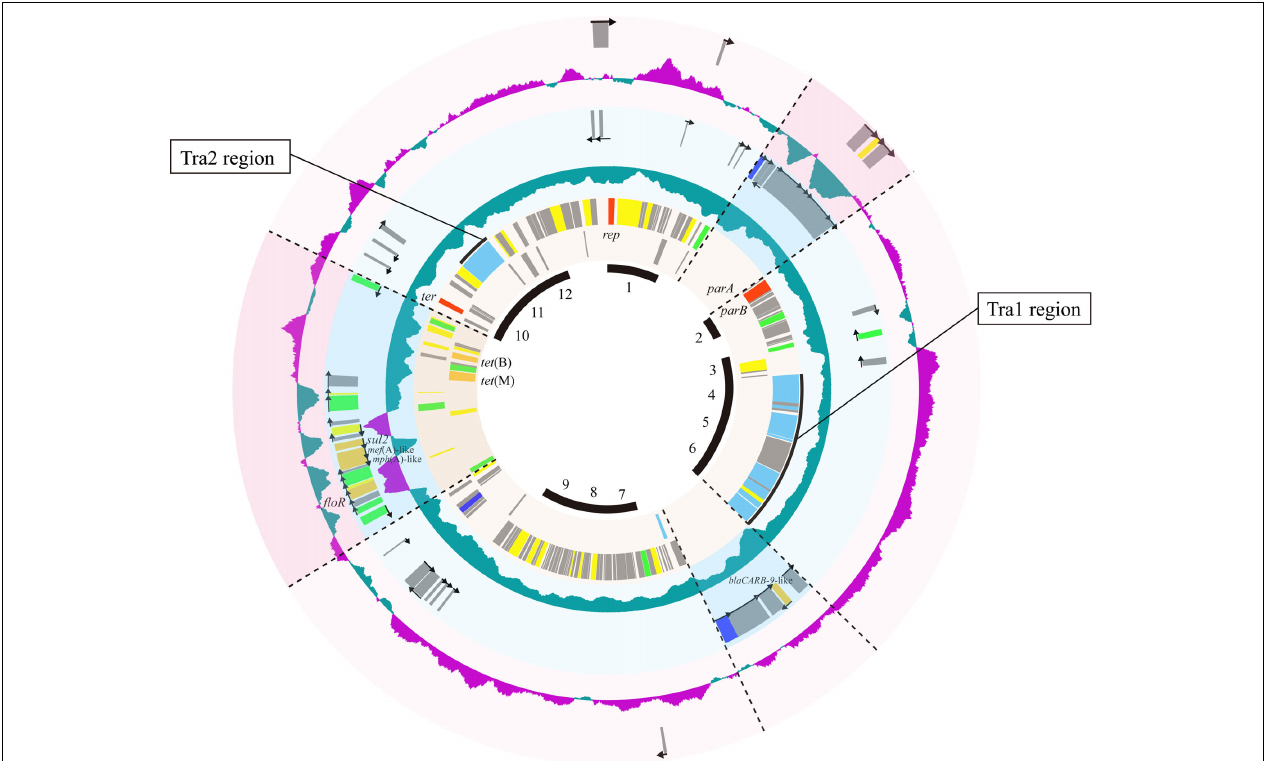
FIGURE 3 | Circular representation of pAQU1 backbone and specific genes for pAQU2 and pAQU1, respectively. Circles from inside to outside: 1, Putative pAQU back bone regions, 2 and 3, shared CDSs between pAQU1 and pAQU2; 5 and 6, CDSs specific for pAQU1; and 8 and 9, CDSs specific for pAQU2. Each of CDSs inside and outside of the circle coded counter-clockwise and clockwise, respectively. The 4th and 7th circle